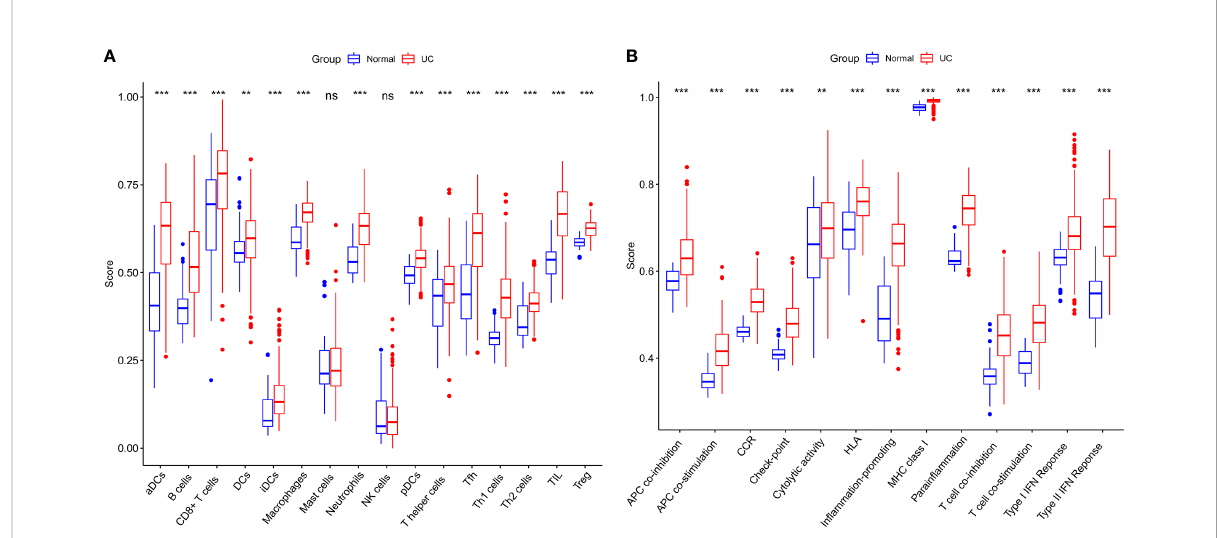
FIGURE 4 (A) Comparison of 16 immune cell subtypes between patients with UC and controls. (B) Comparison of 13 immune function subtypes between patients with UC and controls. *p < 0.05 compared to the normal, **p < 0.01 compared to the normal, ***p < 0.001 compared to the normal, ns p > 0.05 compared to the